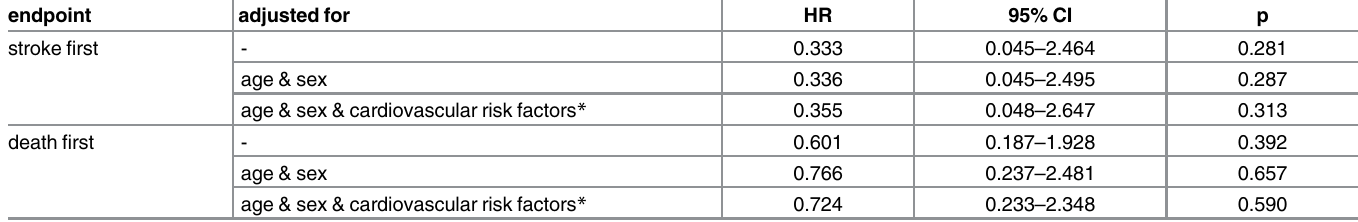
Table 6. Multivariate analysis for cryptogenic stroke